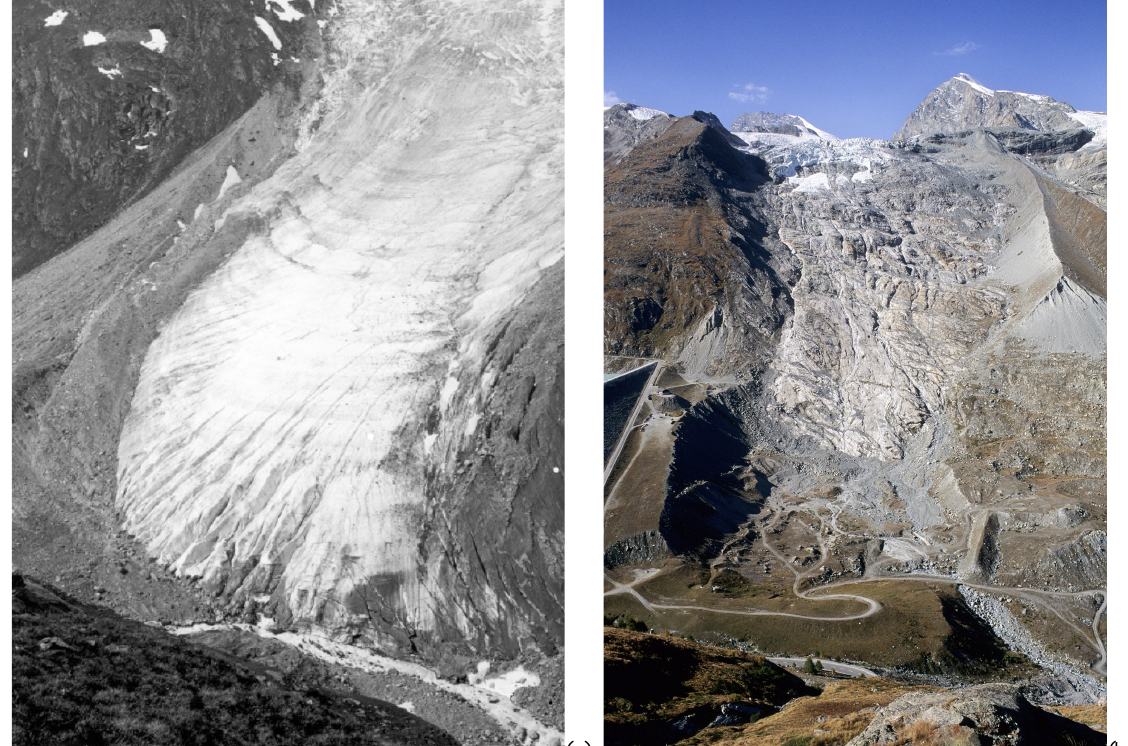
Fig. 2. Allalingletscher (a) in 1916 (O. L¨utschg MZA Zurich, 1.7.1916, Archives of the Glacier Commission, Swiss Academy of Sciences) and (b) in 2004 (photo Archive VAW).